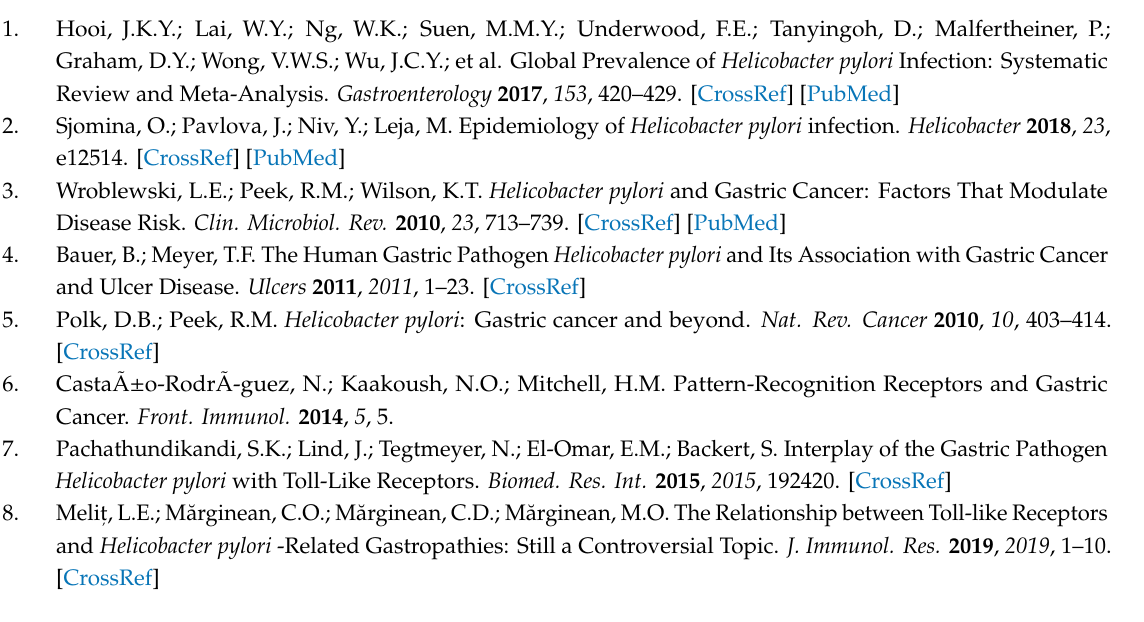
Table S1: H. pylori strains and mutants used in this